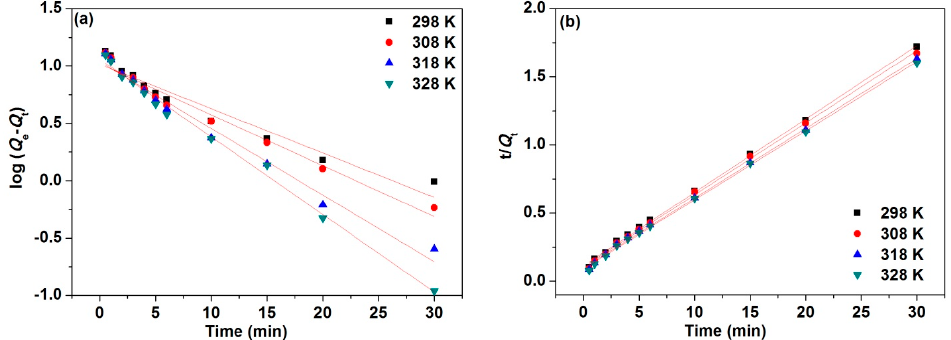
Figure 7. Fittings of iron adsorption by Rexp-501. ( a ) Lagergren pseudo first order model; ( b ) Lagergren pseudo second order model.